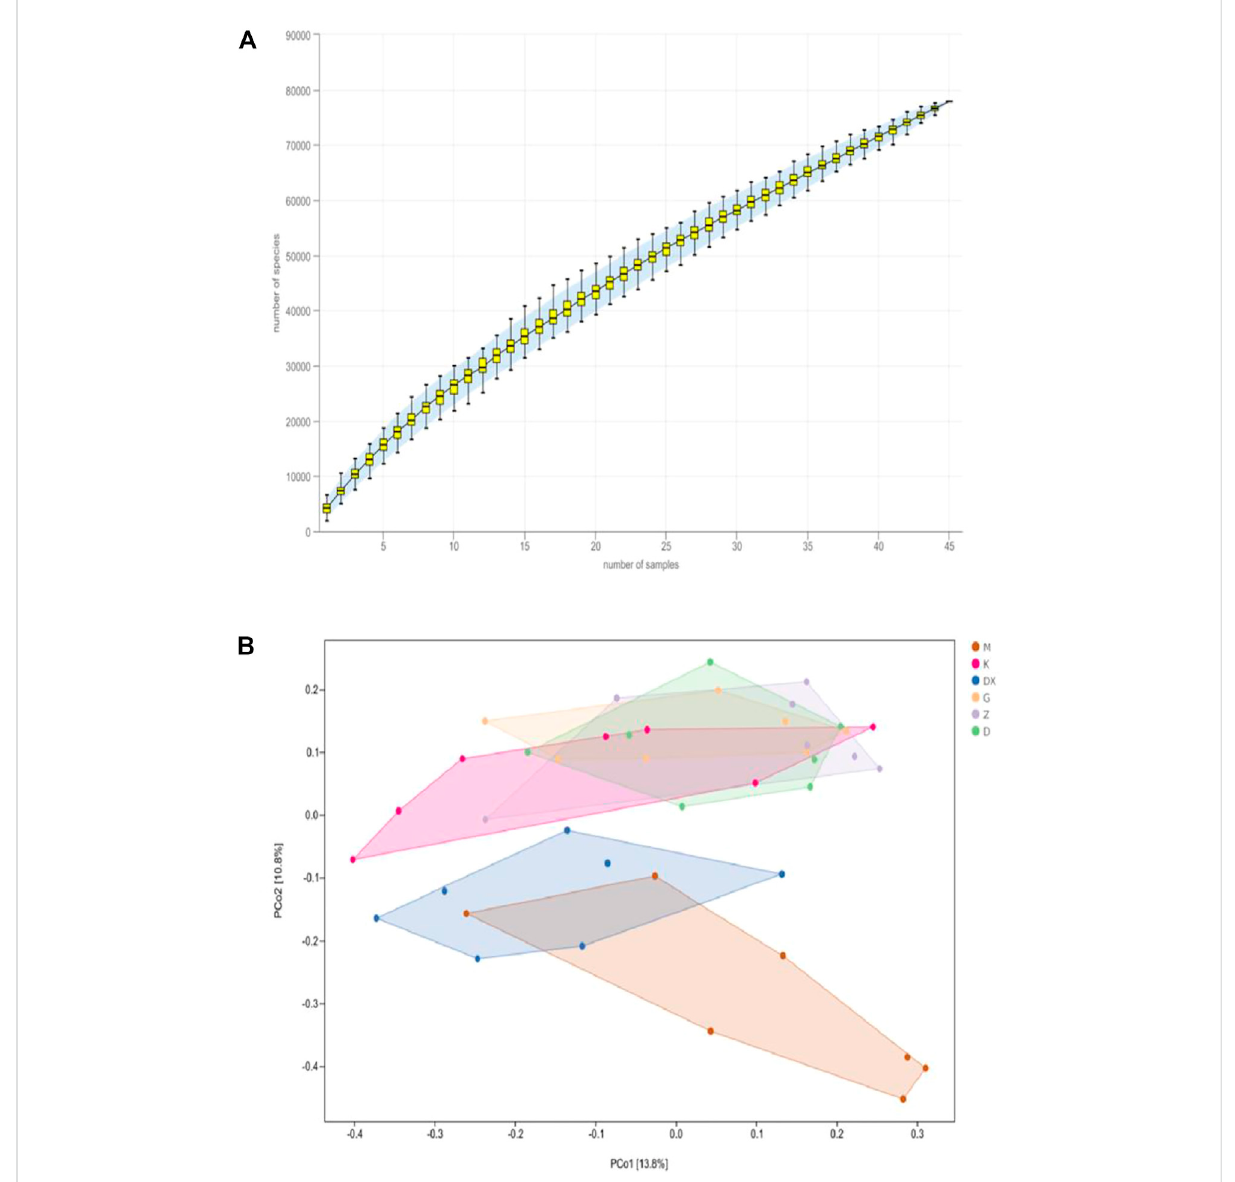
FIGURE 9 Effects of R-S on species accumulation curve (A) and principal coordinate analysis (B) of intestinal micro fl ora in rats with insomnia ( n = 7).